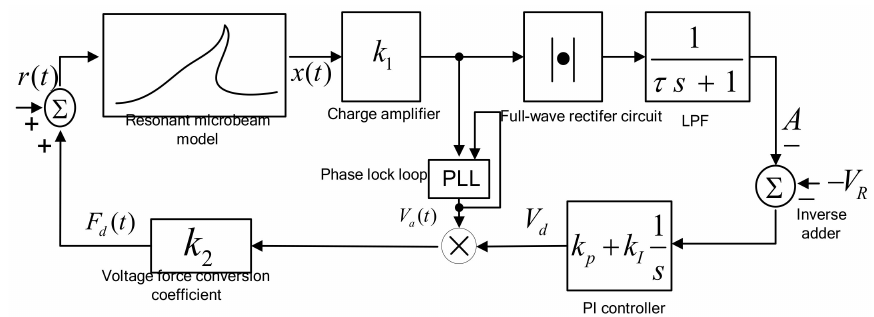
Figure 8. Block diagram of resonant microaccelerometer.